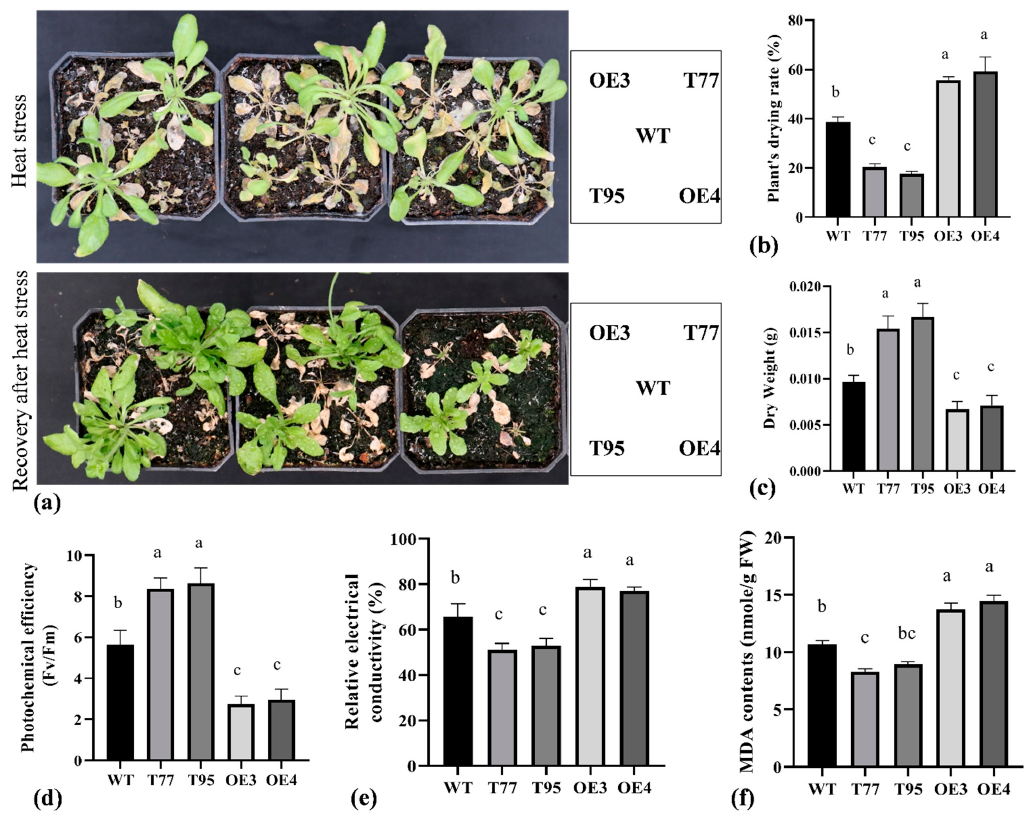
Figure 7. Comparison of heat stress tolerance of overexpressing TrHSFB2a lines and RNA interference T-DNA lines with wild type grown in nutrient soil (peat moss, vermiculite and perlite, 3:1:1) for 25 days and transferred to an incubator adjusted with 35 °C temperature. ( a ) Display Arabidopsis phenotypes after high-temperature treatment and recovery of plants after transferring to normal growth conditions. ( b – f ) display graphical representations of plants drying rate (%), dry weight (g), photochemical efficiency (Fv/Fm), relative electrical conductivity (%) and MDA contents (nmole/g FW), respectively. Bars represent mean ± SD values, and different small letters (a, b and c) represent significant statistical difference among means (one-way ANOVA, followed by Tukey test) between different lines.